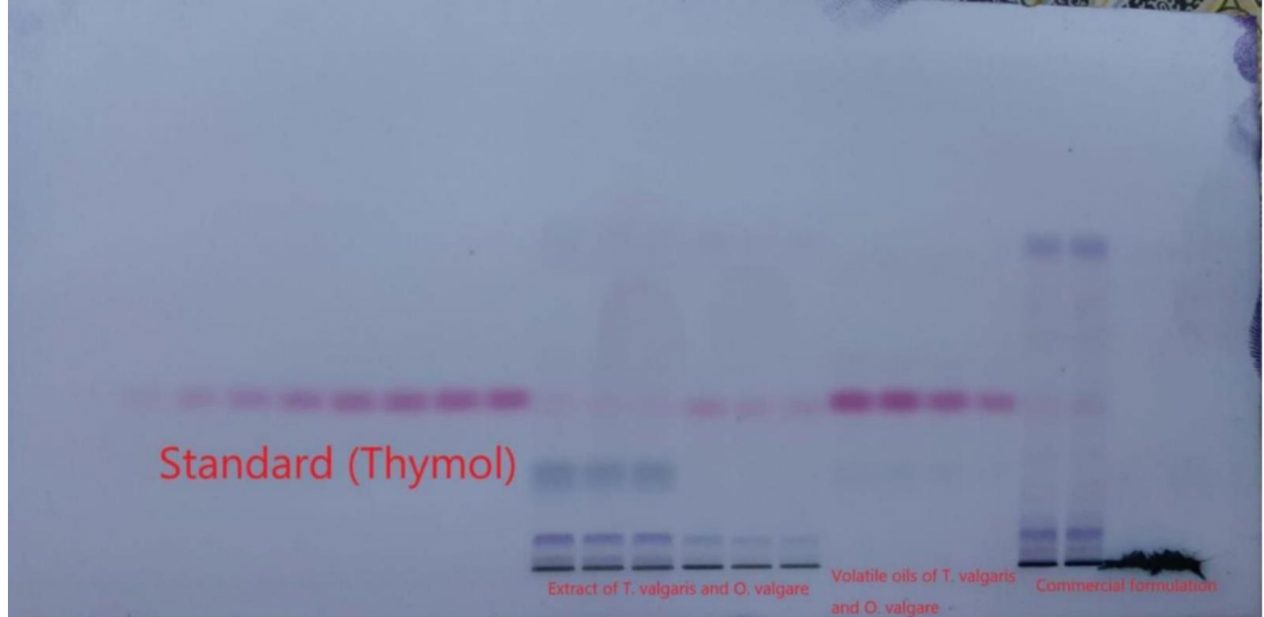
Figure 1. Thin-layer chromatography (TLC)-plate for standard thymol, essential oils, extracts, and commercial formulation developed using CY-EtOAc (85:15, v/v ) as the greener mobile phase after derivatization using anisaldehyde-sulfuric acid under chamber saturation conditions for the greener normal-phase HPTLC